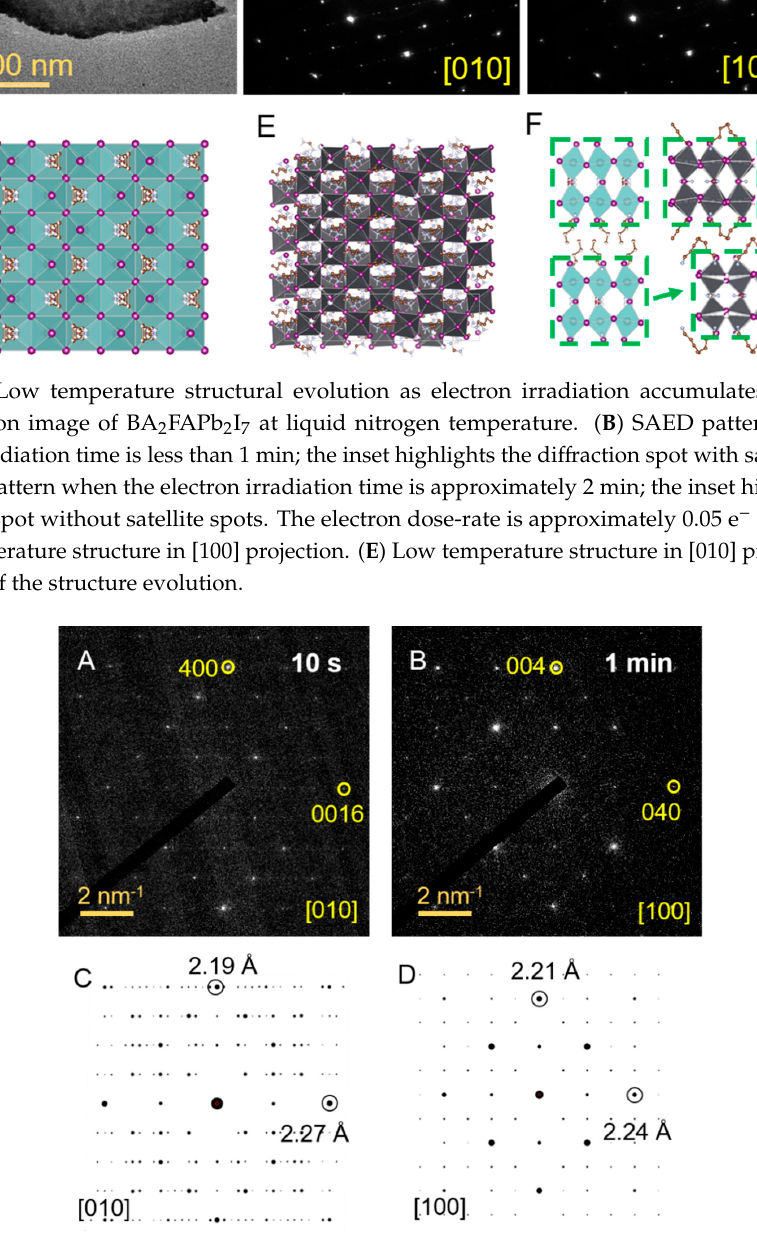
Figure 7. Diffraction evolution as electron irradiation accumulates. ( A , B ) SAED acquired when the sample is exposed to electron beam after 10 s and 1 min respectively. ( C ) Simulated kinematical SAED pattern of low temperature BA 2 FAPb 2 I 7 structure, which is solved at 150 K. ( D ) Simulated kinematical SAED pattern of BA 2 MAPb 2 I 7 , which is solved at 310 K.